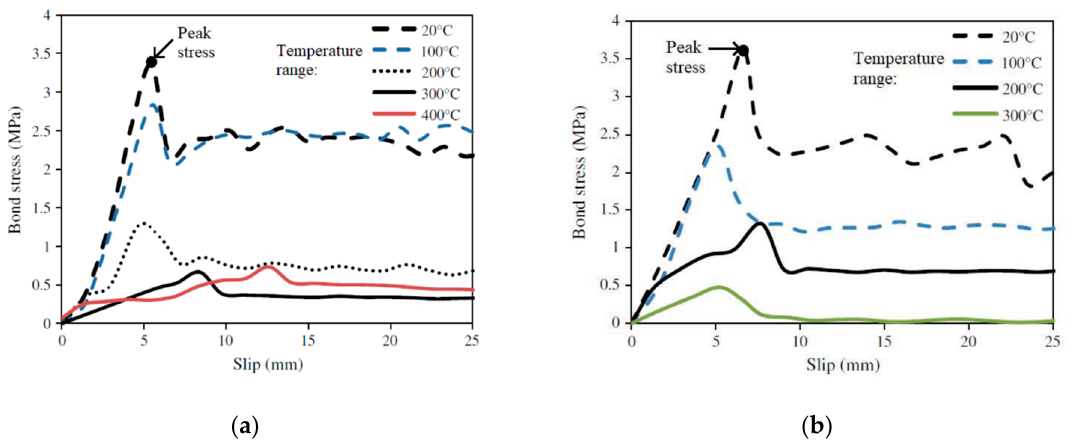
temperatures; ( a ) NSM CRFP strip. ( b ) NSM CFRP rod.